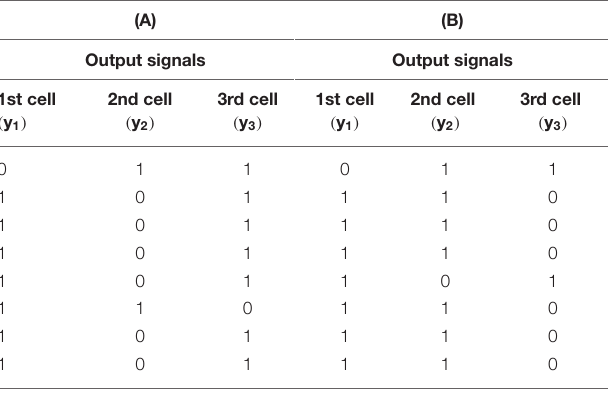
TABLE 3 | (A) Truth table for the logic gate with knockout perturbation {1 0 1} (three coupled cells in cyclic array) σ inh = 35 s − 1 , k ADP = 0.1 s − 1 . (B) Truth table for the logic gate with knockout perturbation {1 1 0} (three coupled cells in cyclic array) σ inh = 35 s − 1 , k ADP = 0.1 s − 1 .